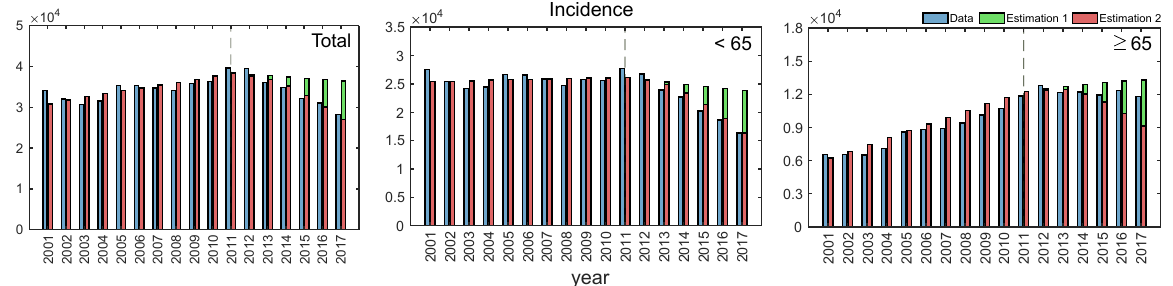
Figure 8. The green bar indicates the results obtained using the same parameter values of the first period (2001–2011), which was extended to the second period (2012–2018) in all three panels. The leftmost panel showed TB incidence data (blue bar) and the model output of the one-age group (red bar). Non-elderly TB incidence of the 2-age group is compared in the middle panel (blue for data and red for model output). Elderly TB incidence data (blue bar) and the model output of the 2-age group (red bar) are compared in the rightmost panel. The green bar increased more in the rightmost panel (elderly TB cases) and decreased slightly in the middle panel (non-elderly TB